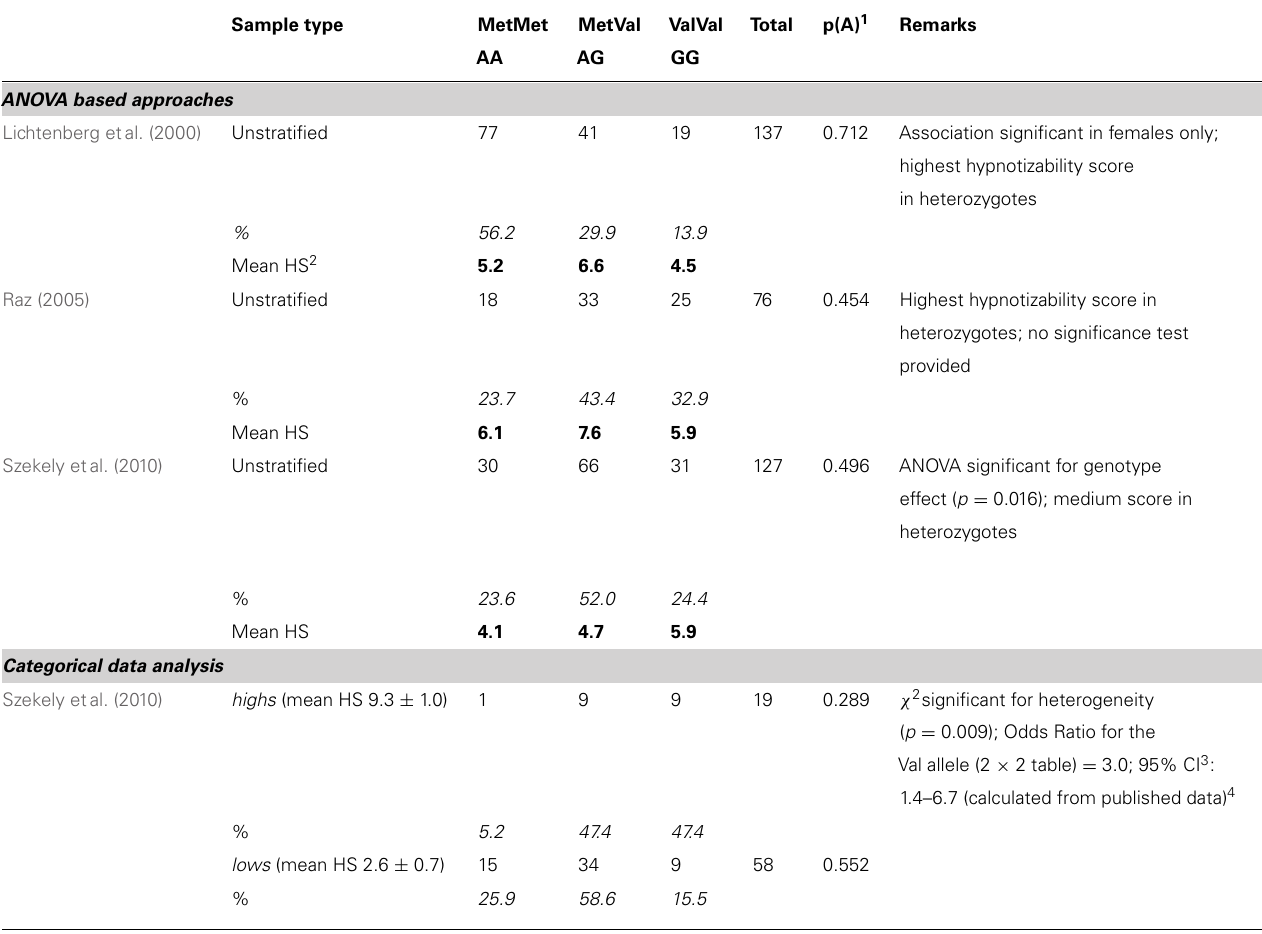
Table 3 | Genetic association studies between the COMTVal 158 Met polymorphism and